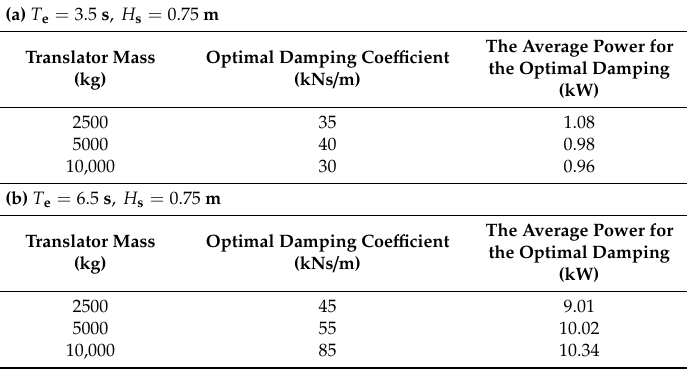
Table 2. The optimal damping coe ffi cients and corresponding power production as a function of translator